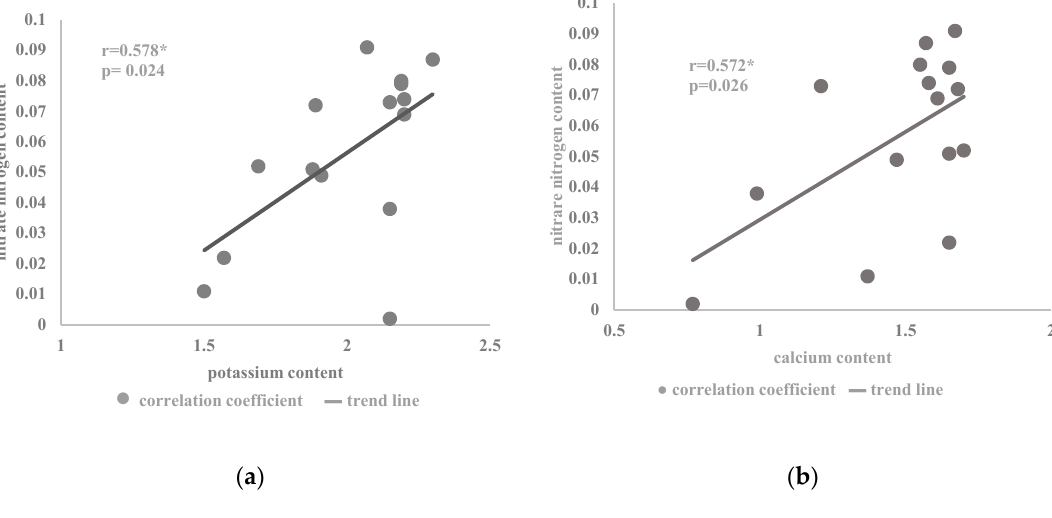
Figure 2. Coe ffi cient of correlation between the content of nitrate nitrogen (% DM) and the content of ( a ) potassium ( b ) calcium in the herb of the summer savory cv. Saturn in relation to the nitrogen dose and plant development phases (Table 2) (* correlation at p <